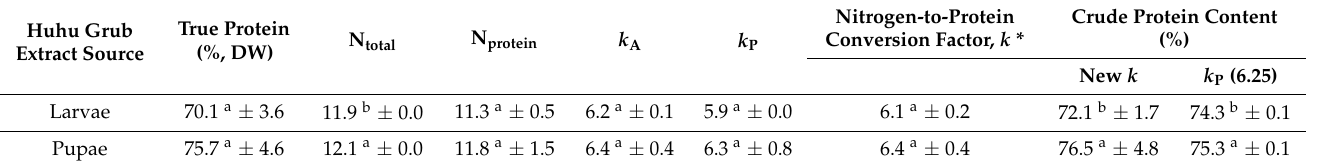
Table 2. True protein content (%, DW), total nitrogen (N total ), nitrogen recovered from amino acids (N protein ), k A (upper limit), k P (lower limit), k (nitrogen-to-protein conversion factor), and crude protein content of Huhu larvae and pupae protein